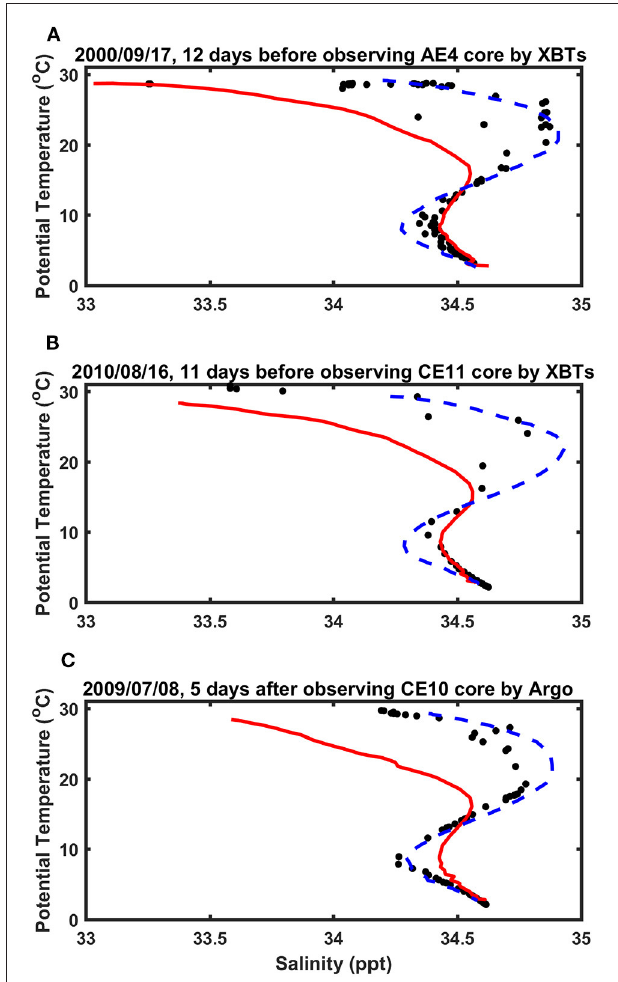
FIGURE 14 | Temperature-salinity (TS) diagrams corresponding to the cases with insignificant eddy pumping and the positive Sverdrup transport, on a particular date closest to day when observing the eddy core via expendable bathythermographs (XBTs). The TS data obtained from (A) the ODB-CTD data for September 17, 2000, (B) the ODB-CTD data for August 16, 2010, and (C) the Argo 2901180 data for July 8, 2009. The solid red and dashed blue curve represents the TS properties of water masses in the southern South China Sea (SCS) and in the Kuroshio region, respectively.